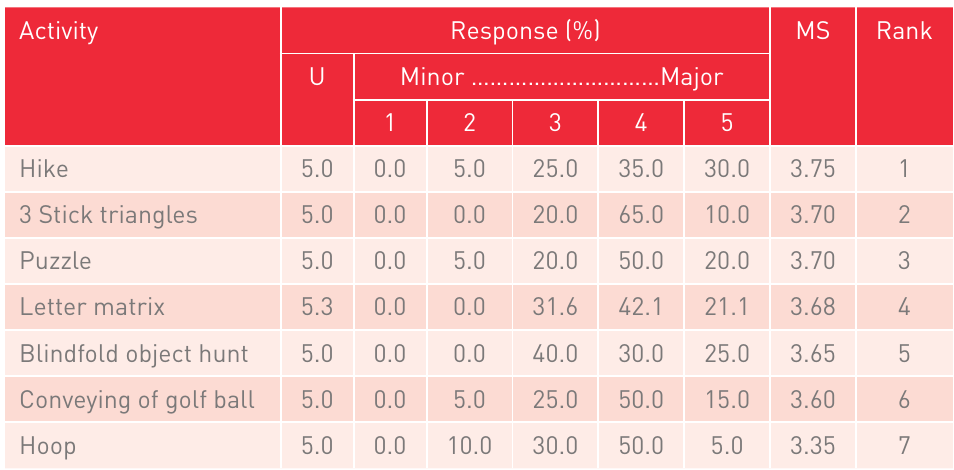
Extent to which the team building activities enhanced participants’ ability to evolve tactics.